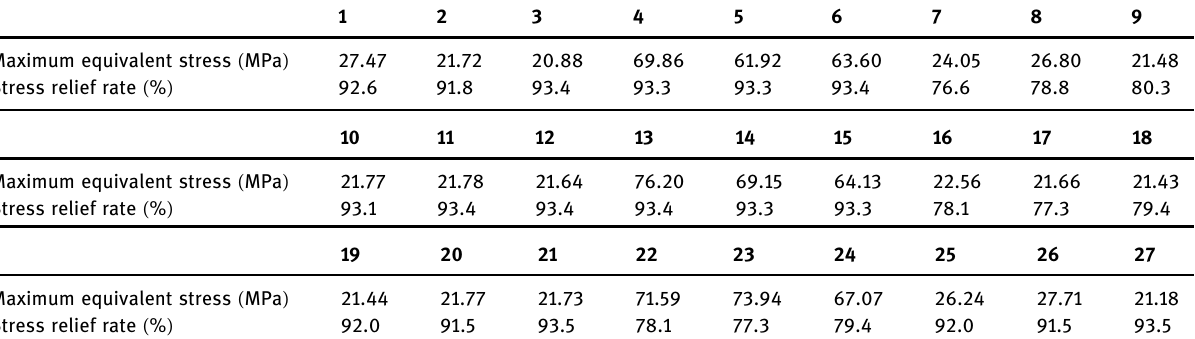
Table 4: The simulation results of orthogonal test of TVSR process